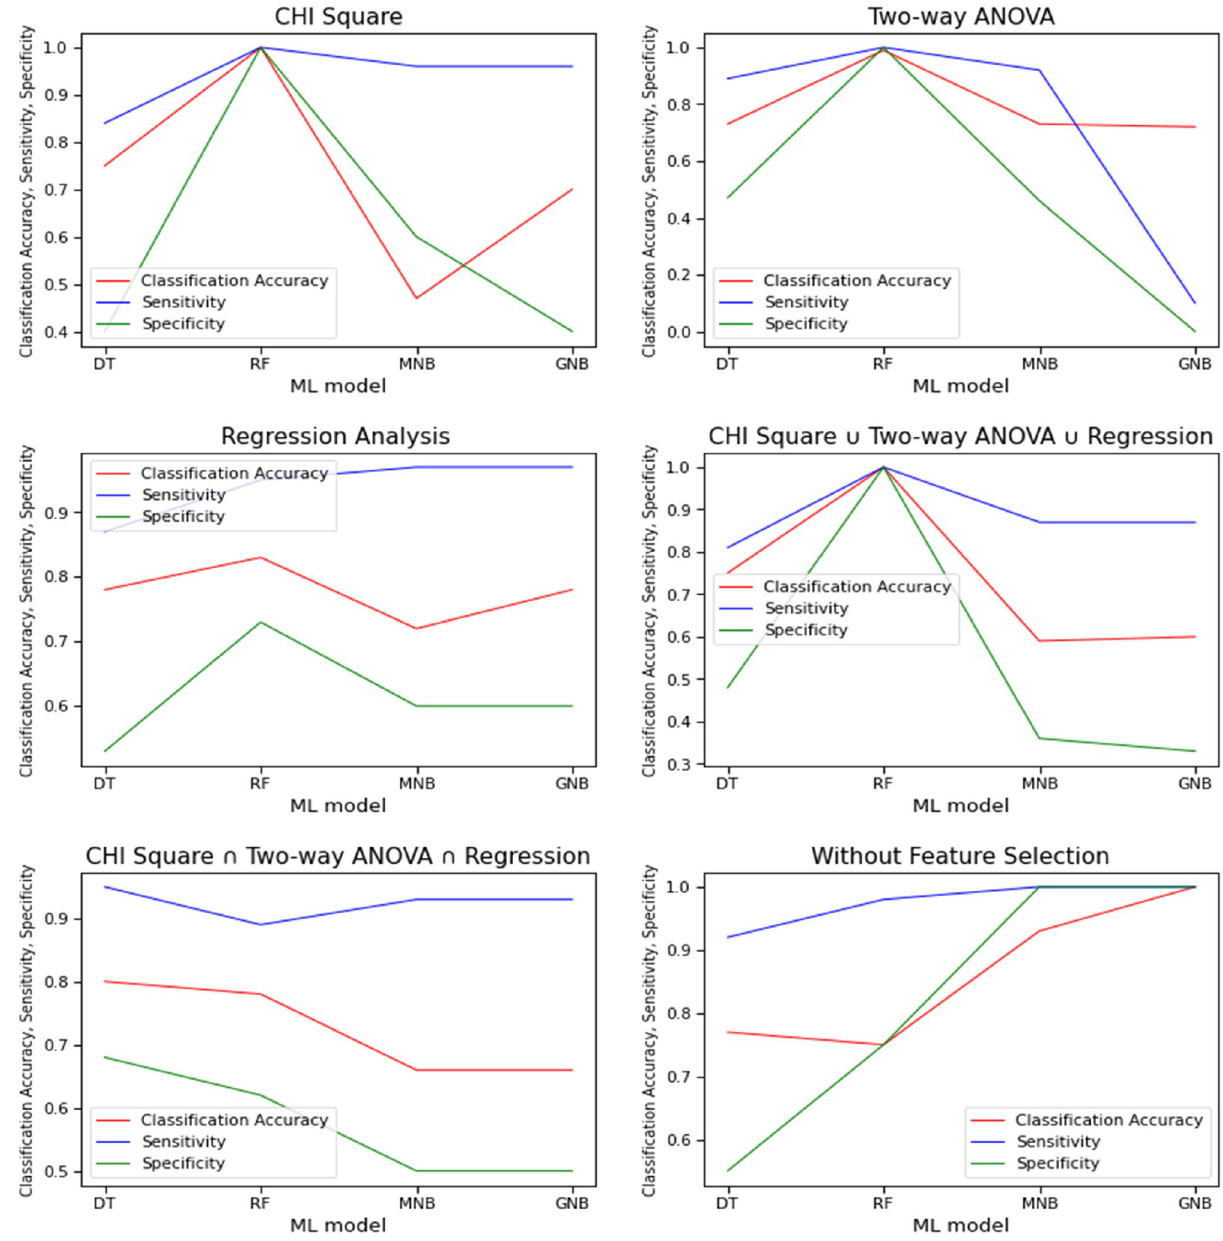
Figure 10. Performance of several machine learning algorithms and feature selection techniques considering accuracy, sensitivity, and